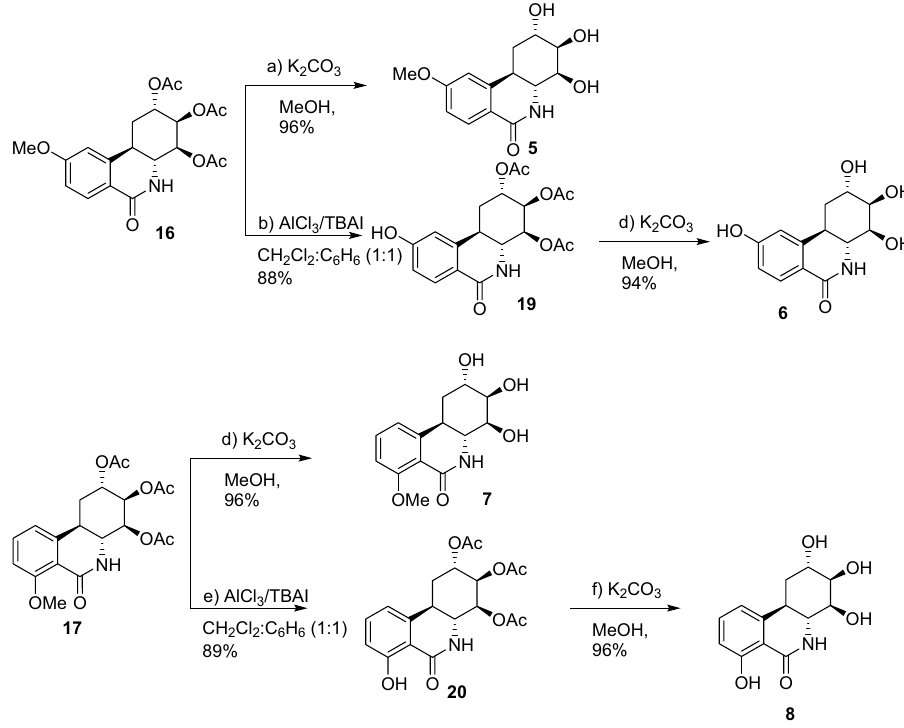
Figure 3. Synthesis of ring-A truncated trans -dihydronarciclasine derivatives ( 5 – 8 ). (a) K 2 CO 3 , MeOH, 95%; (b) AlCl 3 /TBAI, CH 2 Cl 2 :C 6 H 6 (1:1) 88%; (C) K 2 CO 3 , MeOH, 94%; (d) K 2 CO 3 , MeOH, 96%; (e) AlCl 3 /TBAI,